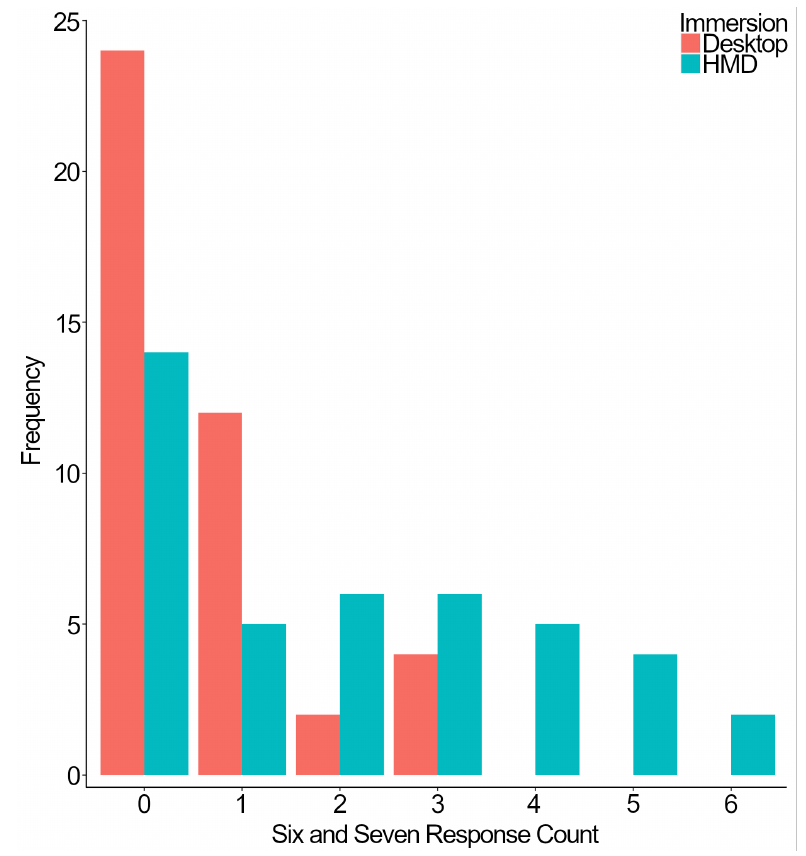
Figure 5. Total count of “six and seven” responses, indicating high presence, in the SUS questionnaire.